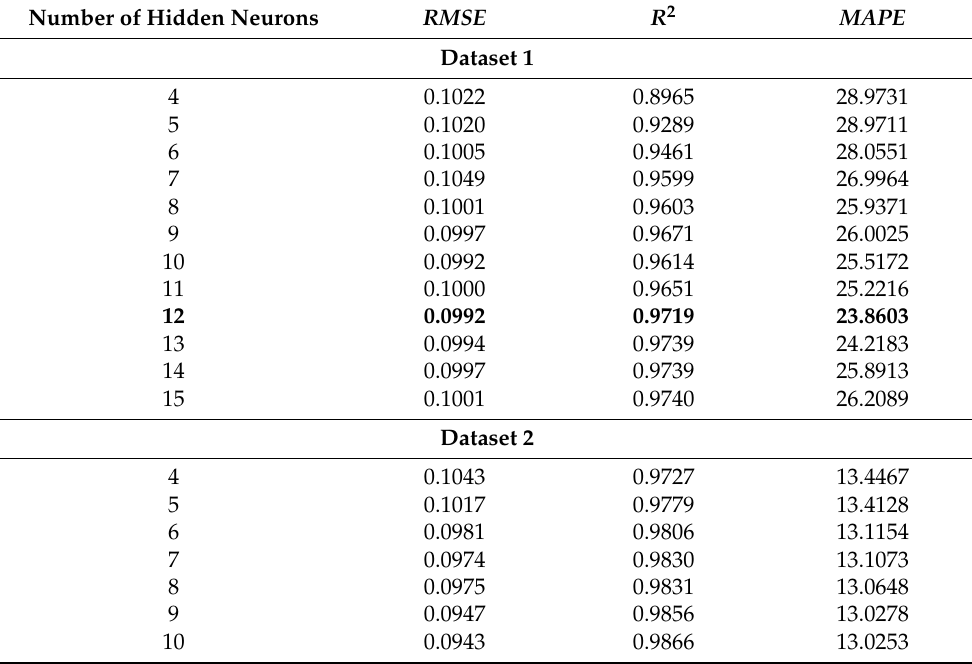
Figure 4. Schematic representation of artificial neural network architecture representing the input parameters and output used in this study. Table 3. Network pruning for optimising different number of neurons in the hidden layer of the ANN model showing the statistical performance indicators. Datasets are single-shot laser peening (dataset 1) and multiple-shot laser peening with overlap (dataset